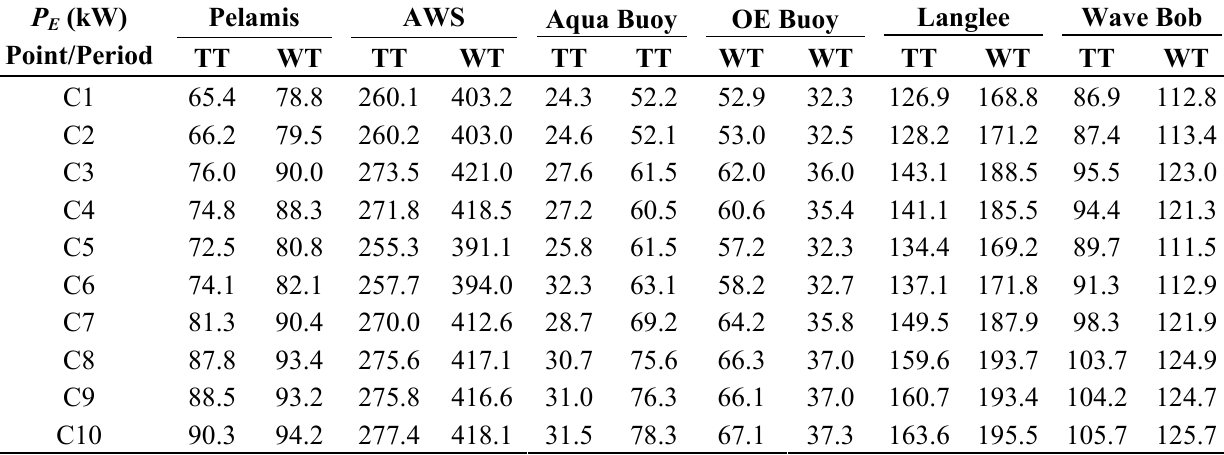
Table 7. Canary Islands, average electric power in kW for the reference points studied, estimations corresponding to the characteristics of six different WEC devices.